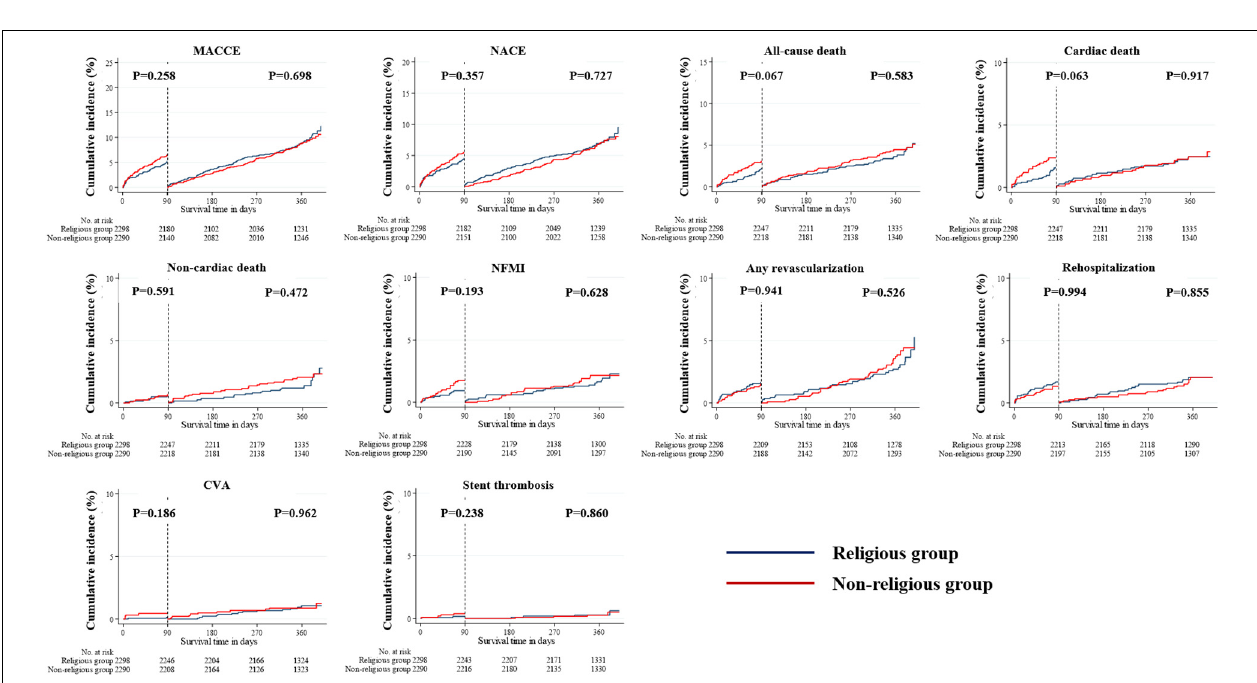
FIGURE 7 | Incidences of primary and secondary clinical outcomes for all patients in a landmark analysis between 90 days and 1 year (after PSM-adjusted analysis). The figure shows the Kaplan–Meier curves for the cumulative event rates according to their religious faith. PSM, propensity score matching.